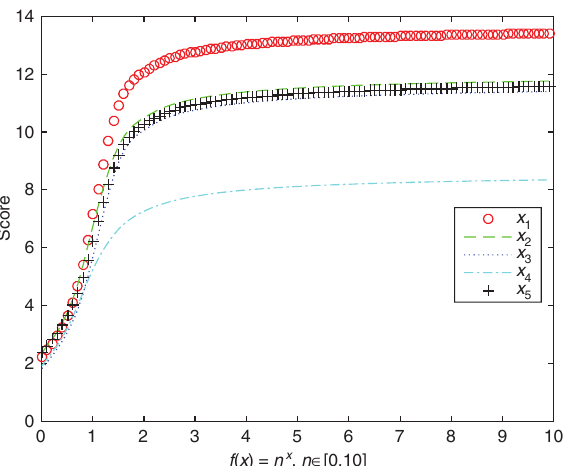
Figure 2: Scores with f ( x ) = n x .